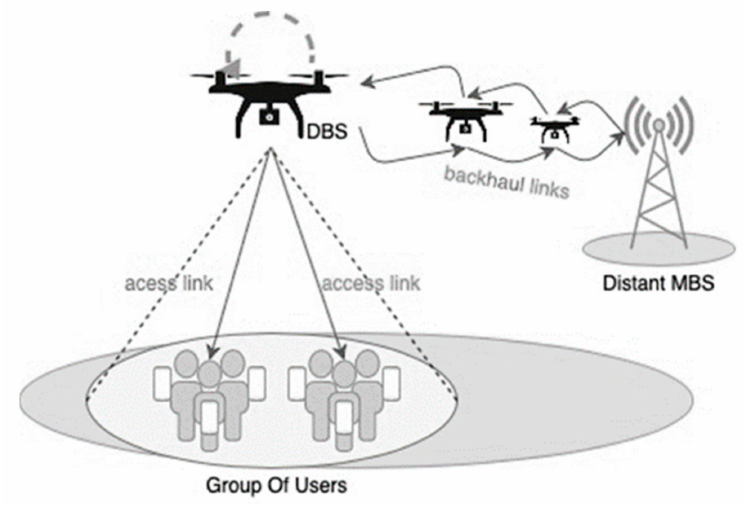
Figure 6. An example of a DBS